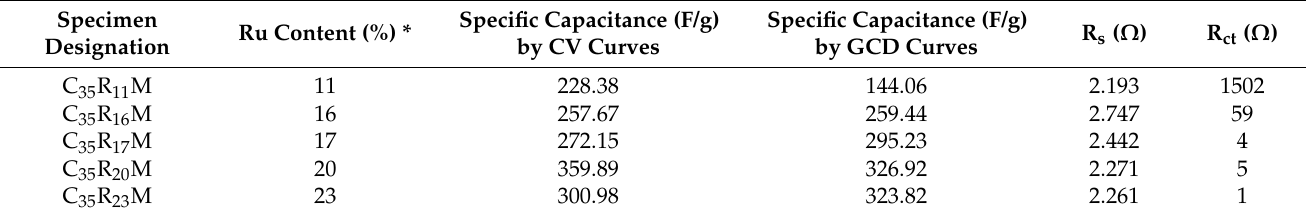
Table 1. The specific capacitances R s and R ct of the C x R y M electrodes evaluated by CV curves, GCD curves and Nyquist plots with various contents of